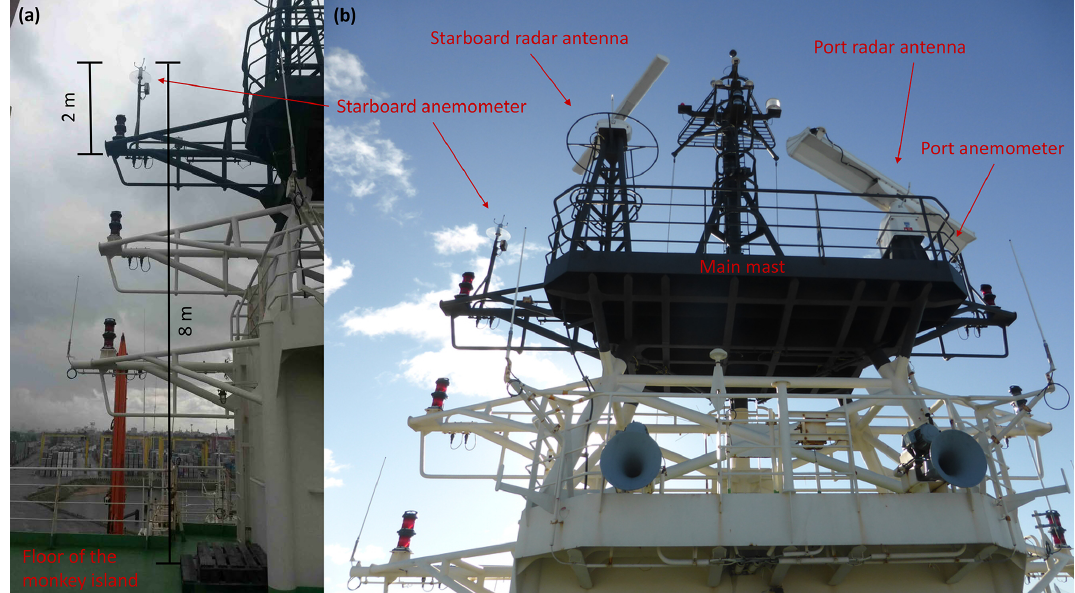
Figure 3. Panels (a) and (b) show annotated photographs of the set-up on the main mast. Photo credits: (a) Irina Gorodetskaya; (b) Jenny